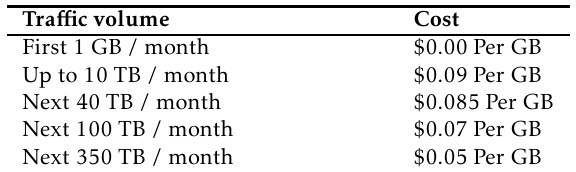
Table 1. Amazon EC2 outgoing data transfer pricing as of February